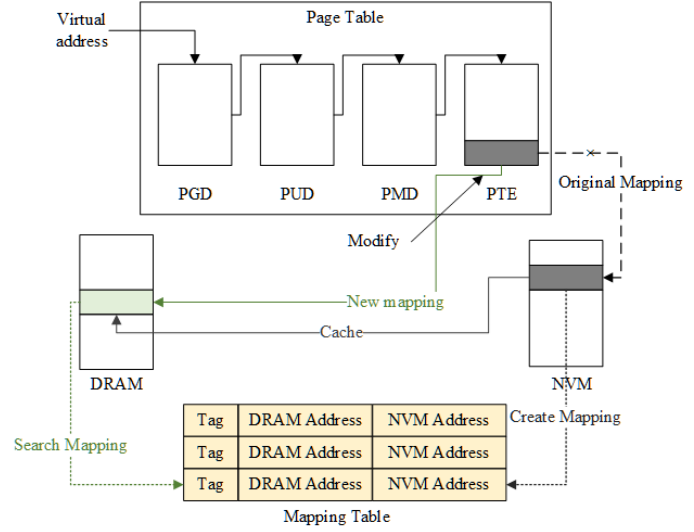
Figure 6. The page migration process in the hierarchical